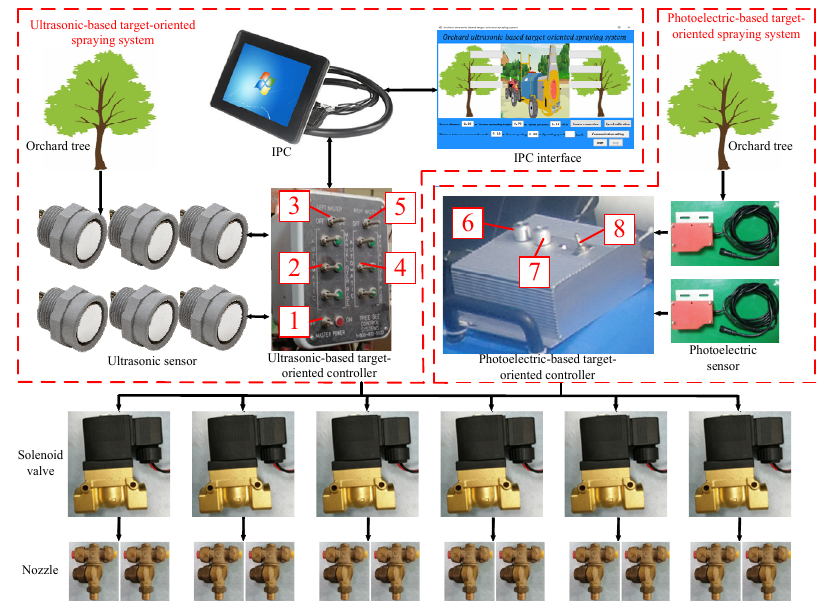
Figure 2. Operation principle of the target-oriented spraying system: 1. master power switch; 2. single-channel control switch of left ultrasonic sensor; 3. master control switch of left ultrasonic sensor; 4. single-channel control switch of right ultrasonic sensor; 5. master control switch of right ultrasonic sensor; 6. spray width adjustment knob; 7. spray delay distance adjustment knob; and 8. master power switch.